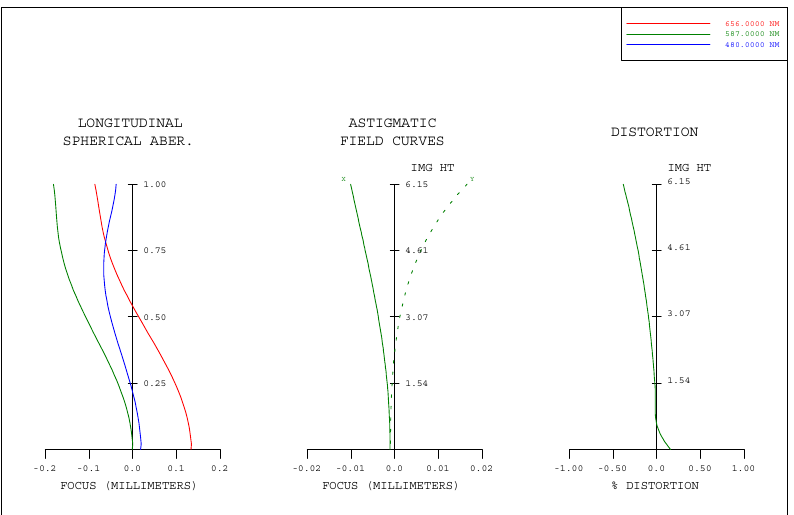
LONGITUDINAL LONGITUDINAL SPHERICAL ABER. SPHERICAL ABER.